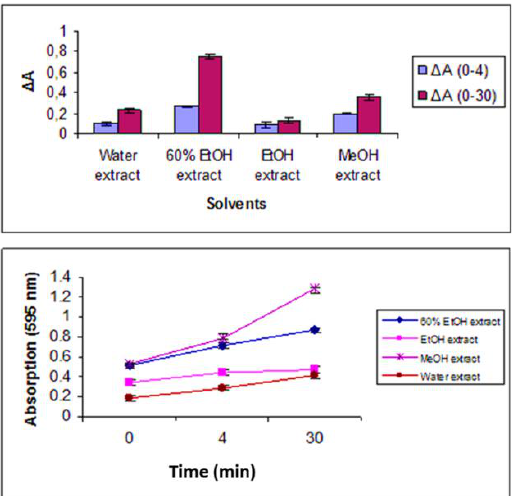
Figure 2. Change in absorbance (presented as ∆ A(0–4) = A 4min − A 0min and ∆ A(0–30) = A 30min − A 0min ) and absorption readings taken at 0, 4, and 30 min for Salvia officinalis extract at 595 nm for 50% EtOH, EtOH, MeOH, and water extract.